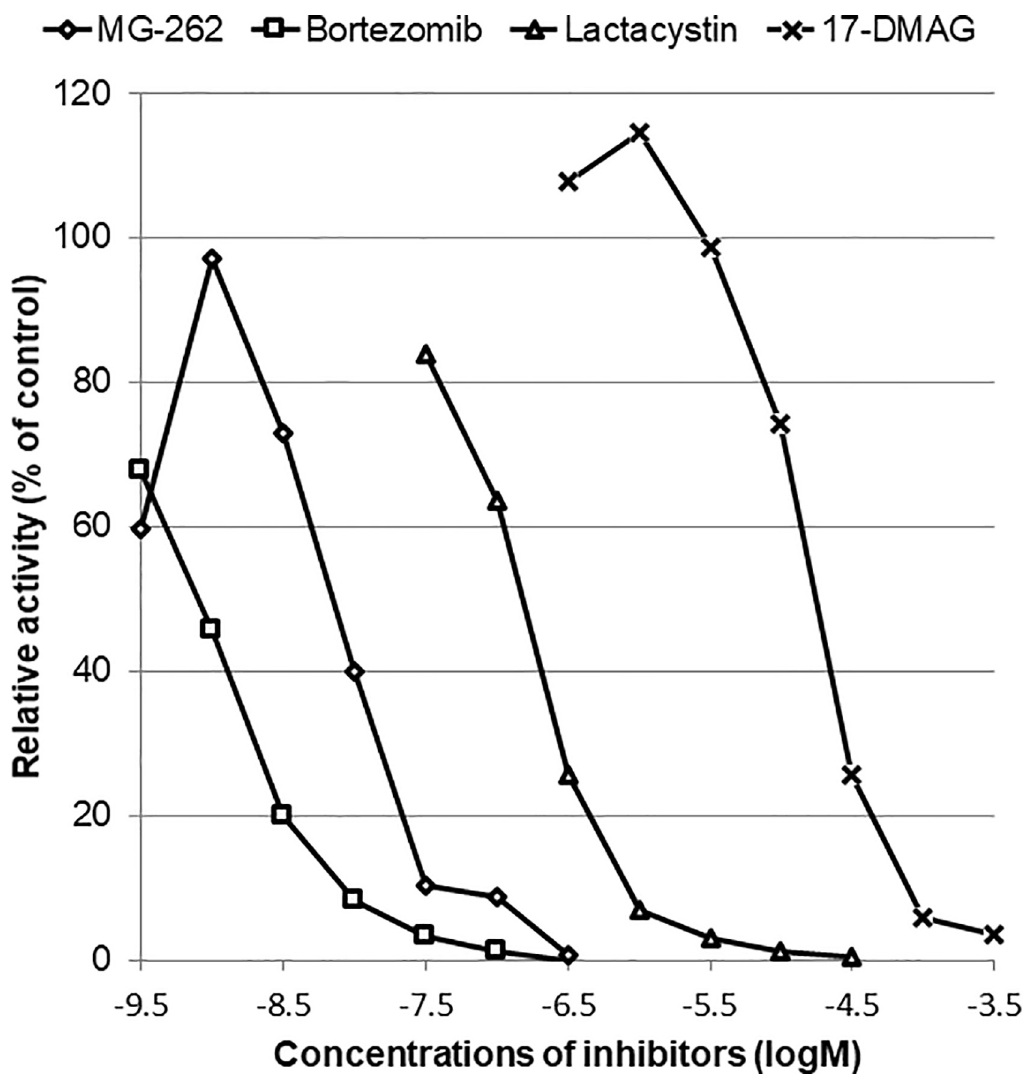
Fig 4. Concentration-response curves for inhibitory effects of MG-262 (open diamond), bortezomib (open square), lactacystin (open triangle) and 17-DMAG (cross) on proteasome activity in a cell-free assay. Proteasome activities were determined by a fluorometric method in the presence or absence of each inhibitor and normalized to the control value in the absence of any inhibitor. The relative activity is shown as percentage of the control. Each value represents the mean of duplicate